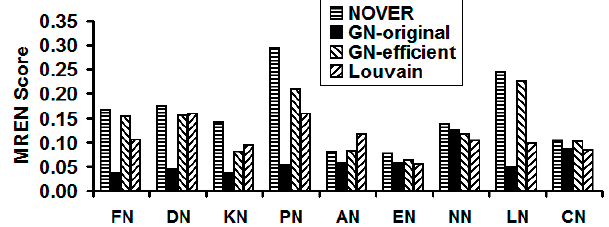
Figure 14. Comparison of the MREN scores of the community detection algorithms on real-world Network graphs.